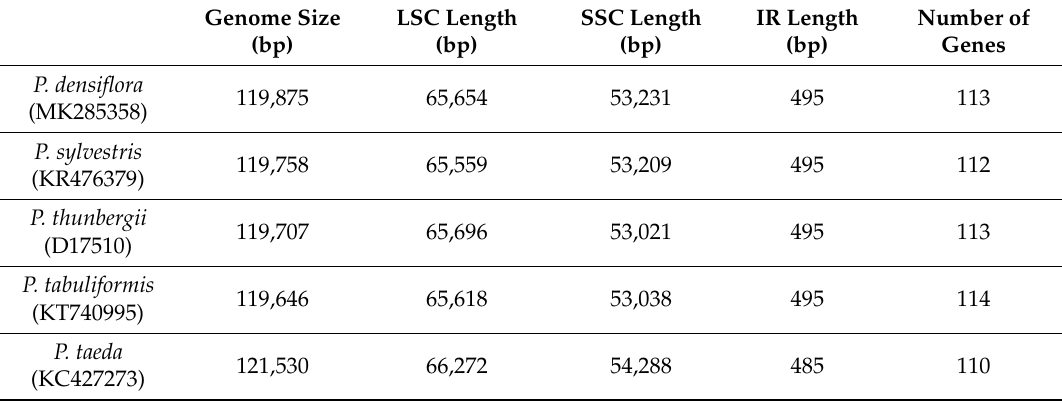
Table 2. Summary of Pinus chloroplast genome features.